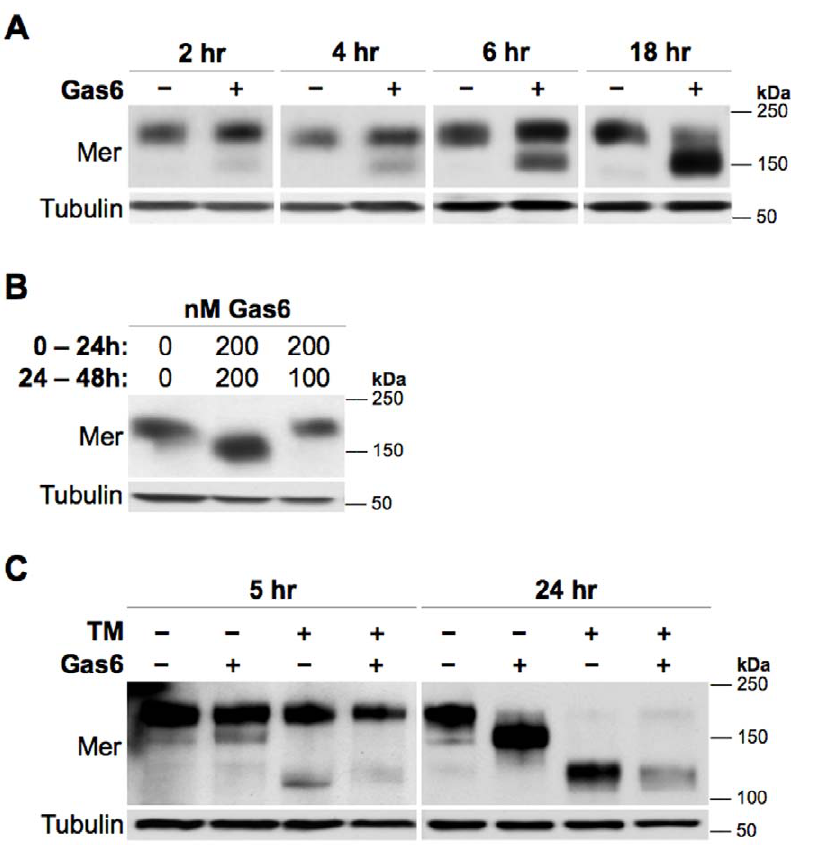
Figure 2. Gas6 induces expression of the partial Mer glycoform in a time- and concentration-dependent manner from a newly synthesized protein. Mer expression was detected by western blot of whole-cell lysates prepared from Jurkat cells. Blots were also probed with an anti-Tubulin antibody to assess loading. ( A ) Equal densities of cells were treated with vehicle control ( 2 ) or 200 nM Gas6 ( + ) and lysed after the indicated exposure times. ( B ) 24 hours after inducing expression of the partial Mer glycoform with 200 nM Gas6, cells were divided into two wells and cultured in media containing 200 or 100 nM Gas6 for an additional 24 hours prior to lysis. Control-treated cells were cultured under the same conditions. The Gas6 concentration during each of the two 24-hour intervals is indicated above the corresponding lane. ( C ) Cells were treated with 1 m g/ml tunicamycin (TM, + , top ) or 0.1% DMSO vehicle control ( 2 , top ) for 1 hour prior to addition of 200 nM Gas6 ( + , bottom ) or vehicle control ( 2 , bottom ). Cells were lysed 5 or 24 hours after Gas6